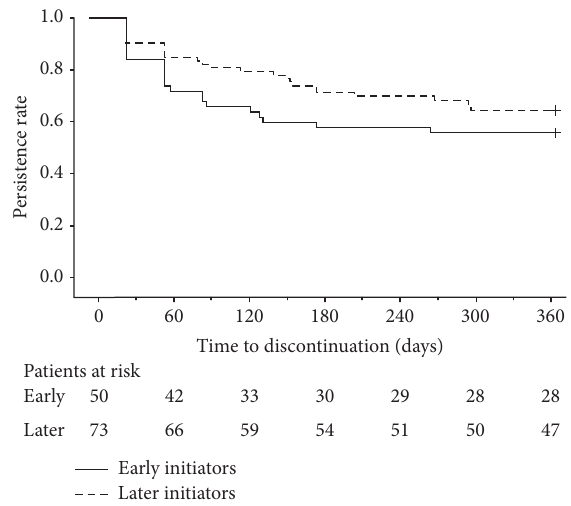
Figure 3: Survival curve for persistence with once-daily teriparatide during the 12-month study period by time frame of treatment. Early initiators started treatment during months 1–4 of once-daily teri- paratideavailability,whereaslaterinitiatorsstartedtreatmentduring months 5–8 of once-daily teriparatide availability. Persistence was definedasthetimefromthestartoftreatmenttothediscontinuation of treatment. Discontinuation was defined as a 60-day gap in once- daily teriparatide supply. + indicates